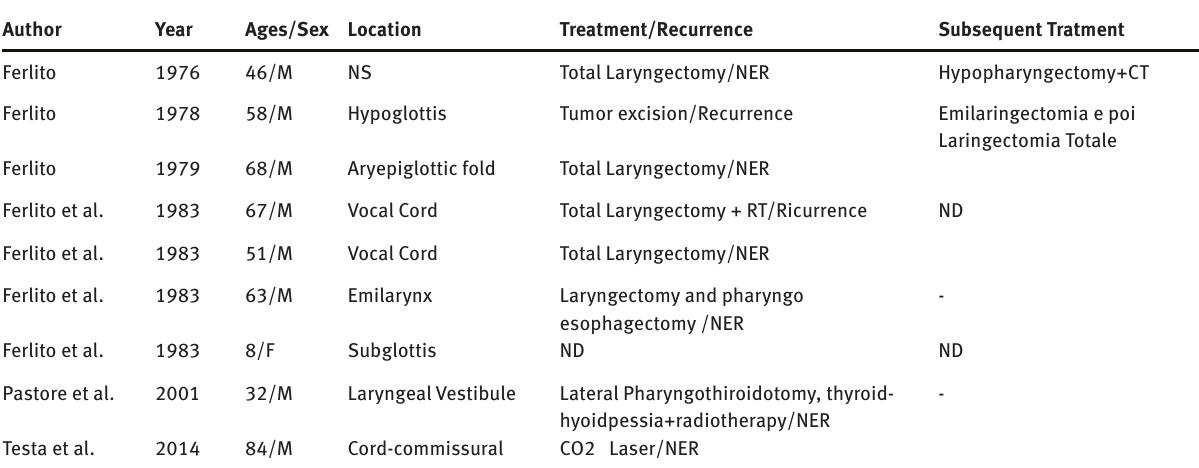
Table 2: Italian cases of MFH of the larynx.